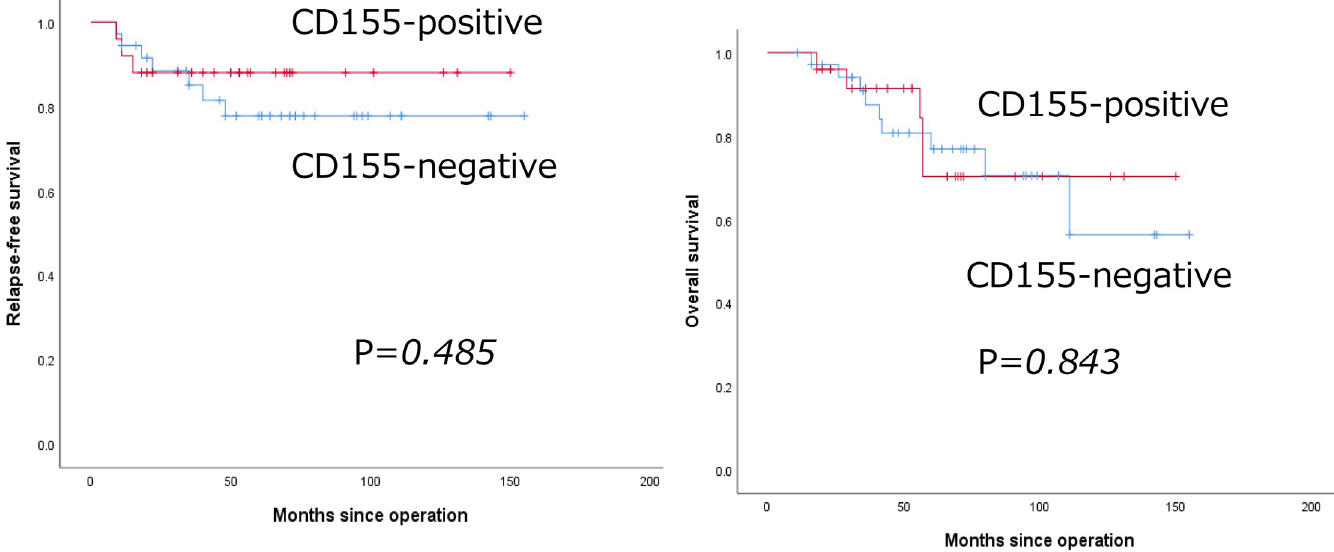
Fig 2. Kaplan–Meier curves for relapse-free survival and overall survival in patients with triple-negative breast cancer. Left: Relapse-free survival curves of CD155-positive (red line) and -negative (blue line) patients. Right: Overall survival curves of CD155-positive (red line) and -negative (blue line) patients.